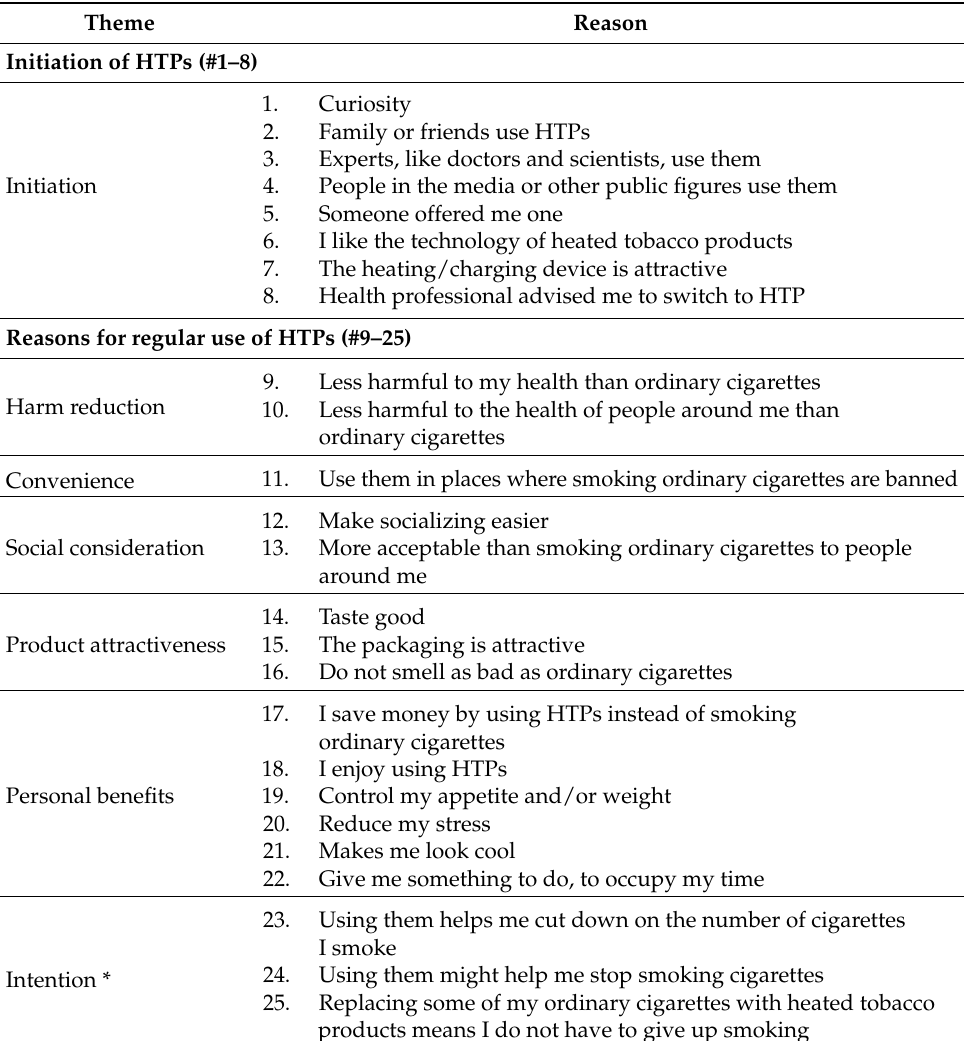
Table 1. Reasons for initiating and regularly using HTPs among HTP-cigarette and exclusive HTP